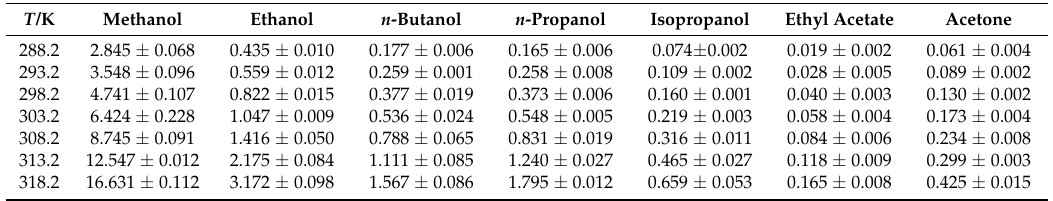
Table 1. Experimental mole fraction solubilities of metoprolol succinate, 10 3 · x exp , in different solvents at temperatures T = (288.2 to 318.2) K under 0.1 MPa. 1